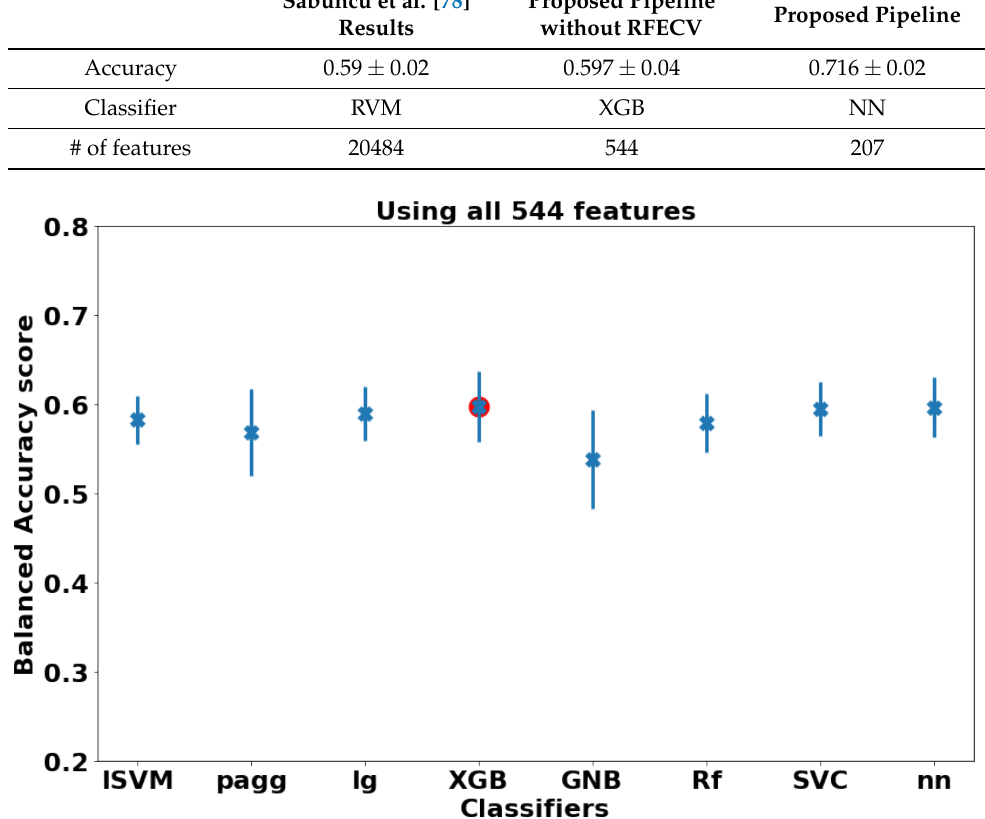
Figure 9. The highest testing balanced accuracy score, plus or minus one standard deviation, achieved by each of the optimized classifiers without applying any feature selection algorithms.The red point labels the classifiers achieving the highest